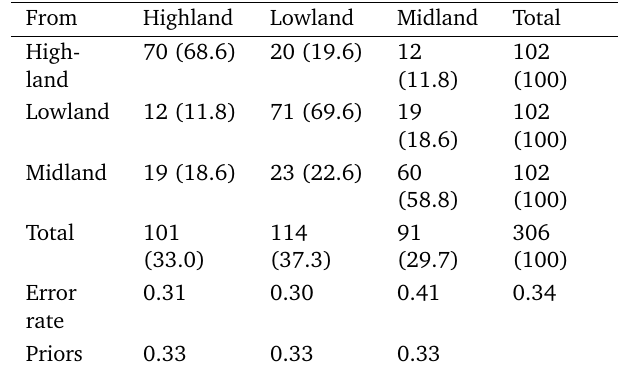
Table 7. Multivariate statistics and F approximates Statistic